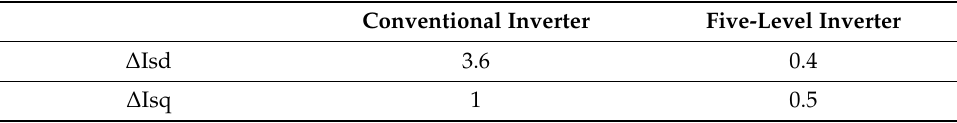
Figure 18. FFT analysis of the Isd and the fundamental harmonic THD: ( a ) conventional inverter; ( b ) five-level inverter. Table 4. Δ Isd and Δ Isd of two- and five-level inverters. Conventional Inverter Five-Level Inverter